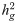
Boxplots for estimates of each component obtained from models ‘G’, ‘K’, ‘F’, ‘S’, ‘C’, ‘GK’, ‘GKC’, ‘GKSC’ and ‘GKFSC’.X-axis: the contributors to the simulated phenotype and the model used (matched model); Y-axis: proportion of total phenotypic variance captured by each design matrix. Yellow lines: simulated value for each component. Parameter settings: hg2 = 0.3, hkin2 = 0.2, ec2 = 0.1, es2 = 0.1 and ef2 = 0.05. For example, the 2nd boxplot of the 3rd graph means that, the simulated phenotypes are contributed by 30%, 20%, 10% and 40% of SNP-associated, pedigree-associated, couple environmental and residual effects respectively; we conducted variance component analyses for all replicates using the matched model ‘GKC’ and the estimates of ec2 range from about 8% to 12% with a mean of 10%, as expected.